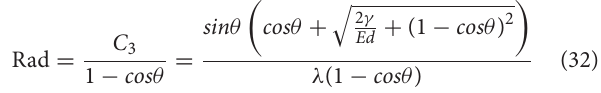
The coordinate of the separation point can be calculated by Eqs. (15) and (16) as ( C 1 , C 3 ). When a circular arc is used to